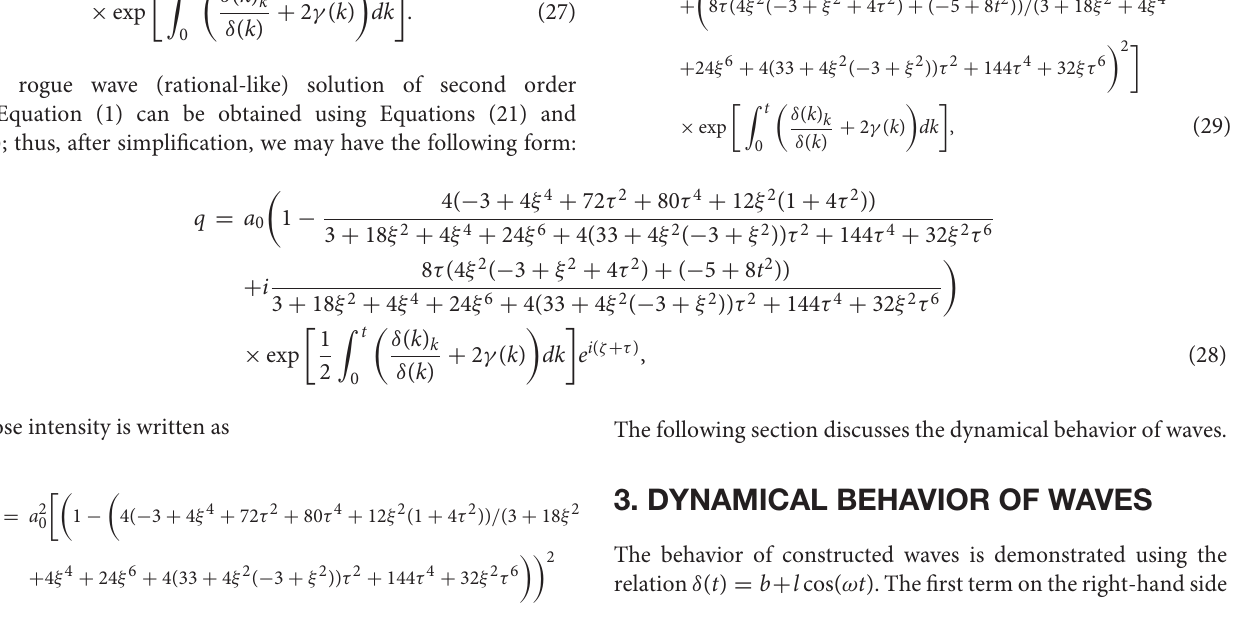
0.5 t 2 and = 0.35 t 2 . =